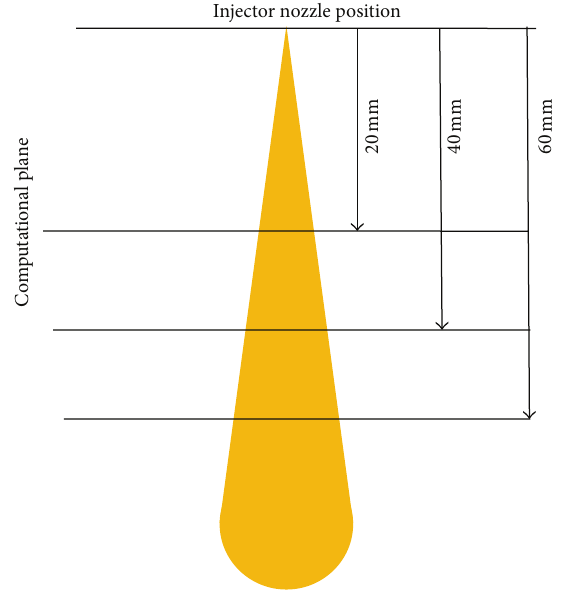
Figure 17: Computational planes located at 20, 40, and 60 mm from injector nozzle position in 𝑍 -direction.